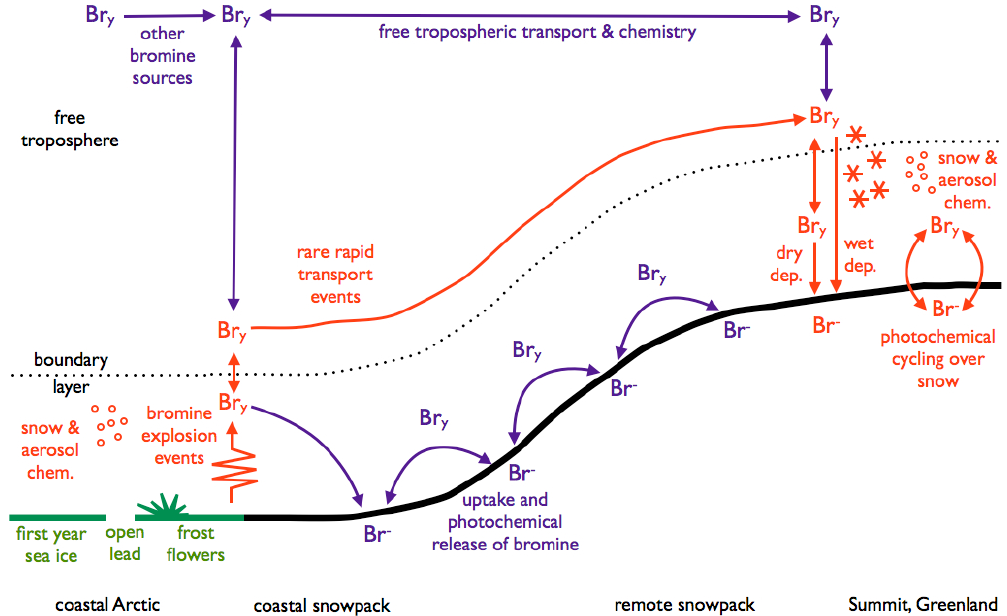
Fig. 2. Schematic of the current understanding of chemical cycling of bromine at Summit and the connections to known bromine sources. We use Br y to refer to both gas and aerosol bromine in the boundary layer and troposphere. Chemical cycling known to occur is shown in red, processes or may occur are shown in purple. Many of the processes in red in have large uncertainties as to their role in tropospheric chemistry as well as their contributing to bromine cycling at Summit. When bromine explosion events occur transport of bromine to Summit may occur via a number of currently poorly characterized pathways and in a number of forms. The source of bromine at Summit is uncertain and should be further studied. In addition, the form of bromine initially deposited to the surface snowpack should be characterized.